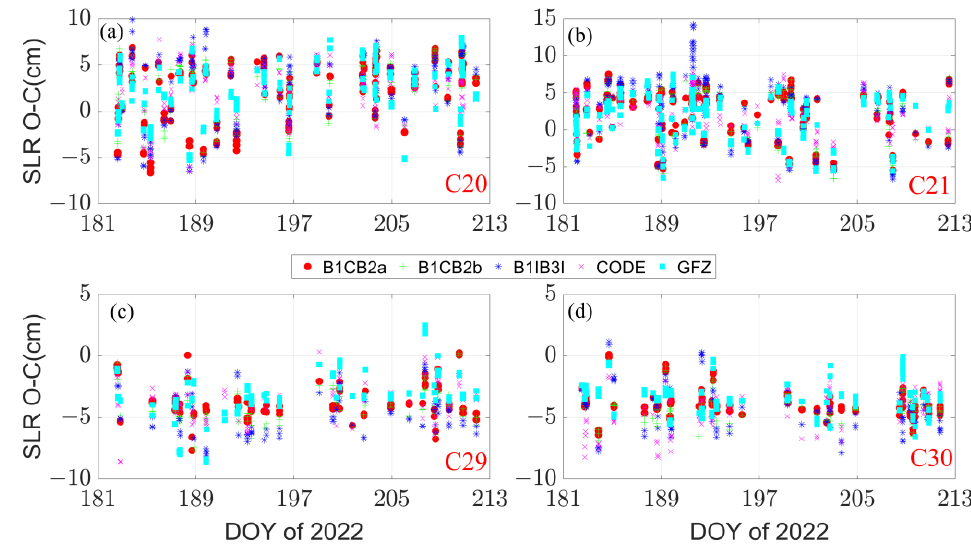
Figure 8. SLR residuals of BDS-3 four MEOs for different solutions. ( a ) for M2/C20, ( b ) for M3/C21, ( c ) for M9/C29, and ( d ) for M10/C30, respectively.